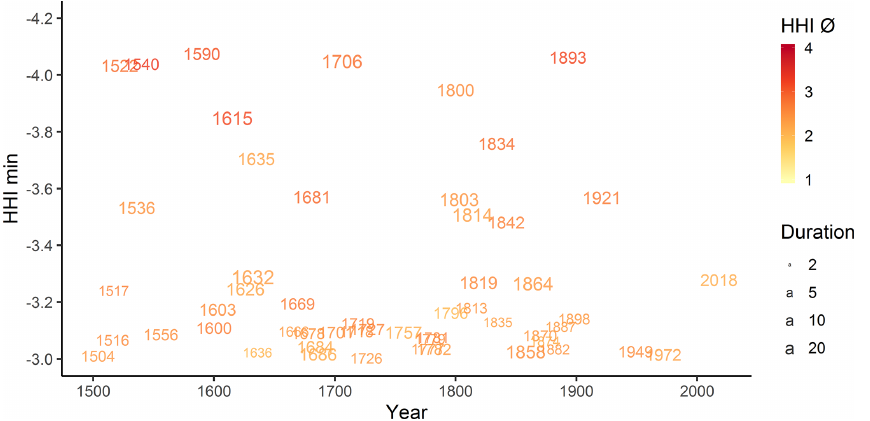
Figure 9. “Yearcloud” of classified years since 1500. The average intensity is reflected by the color scheme and duration (month) by font